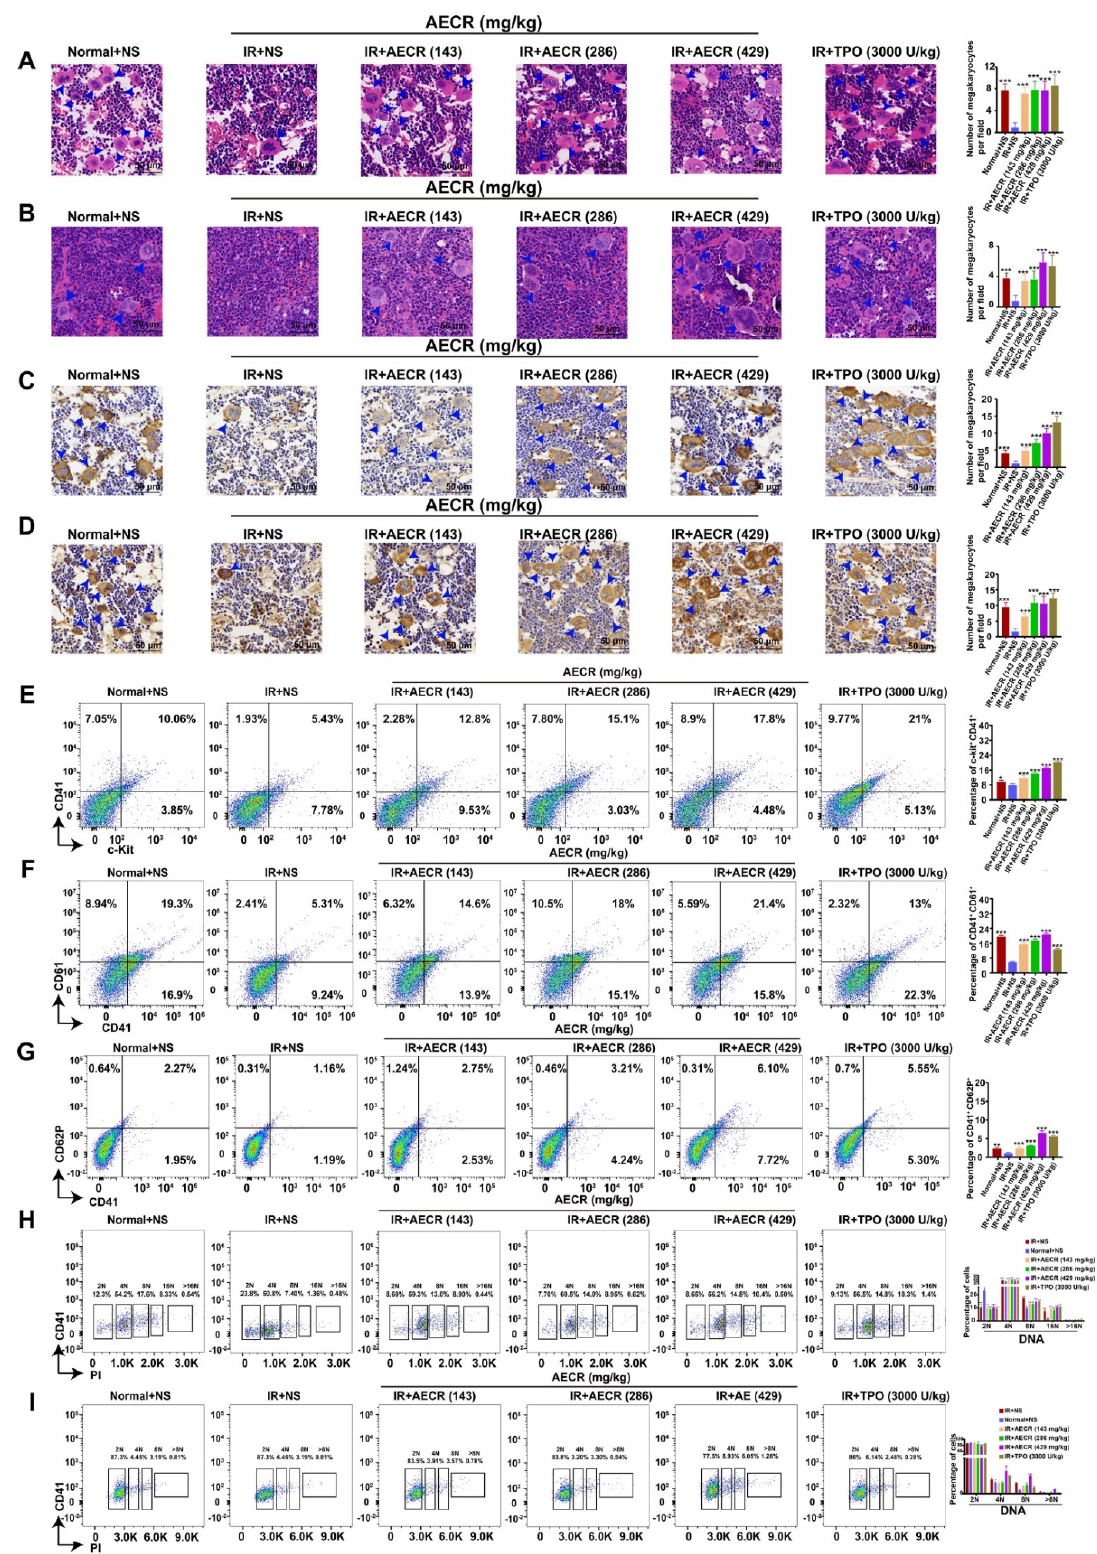
Figure 5. AECRs promoted the differentiation and maturation of BM and splenic megakaryocytes at 10 days. ( A , B ) H&E staining shows that the megakaryocytes from BM and the spleen were increased after AECR (143 mg/kg, 286 mg/kg, and 429 mg/kg) and TPO treatment (blue arrowheads). On the right, this statistical histogram shows cell proportions in each group. The values represent